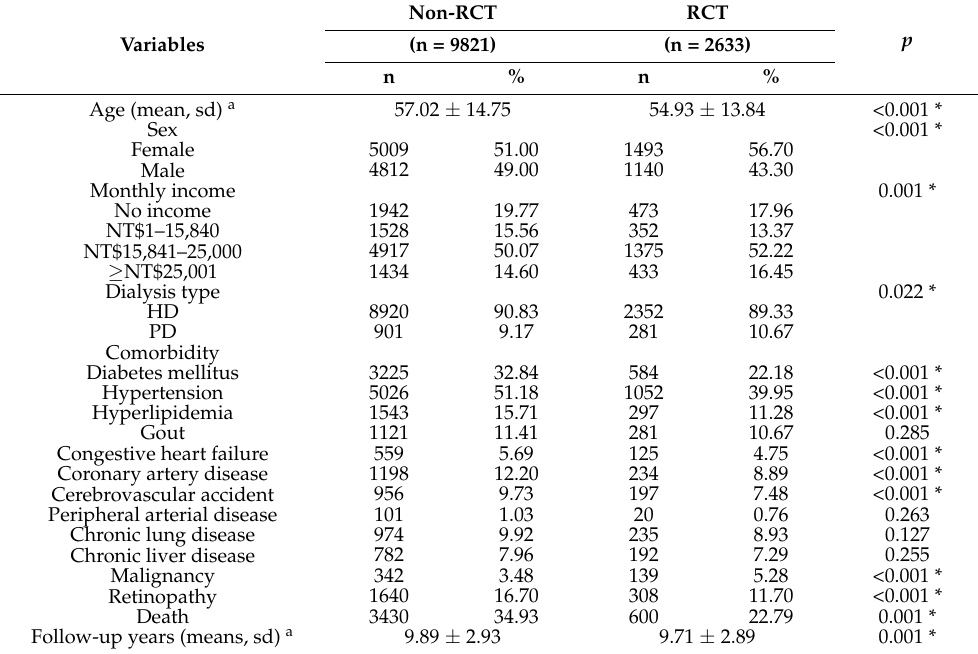
Table 1. Demographic characteristics of dialysis patients with and without root canal therapy (RCT) in the years 2000–2015 (n = 12,454).